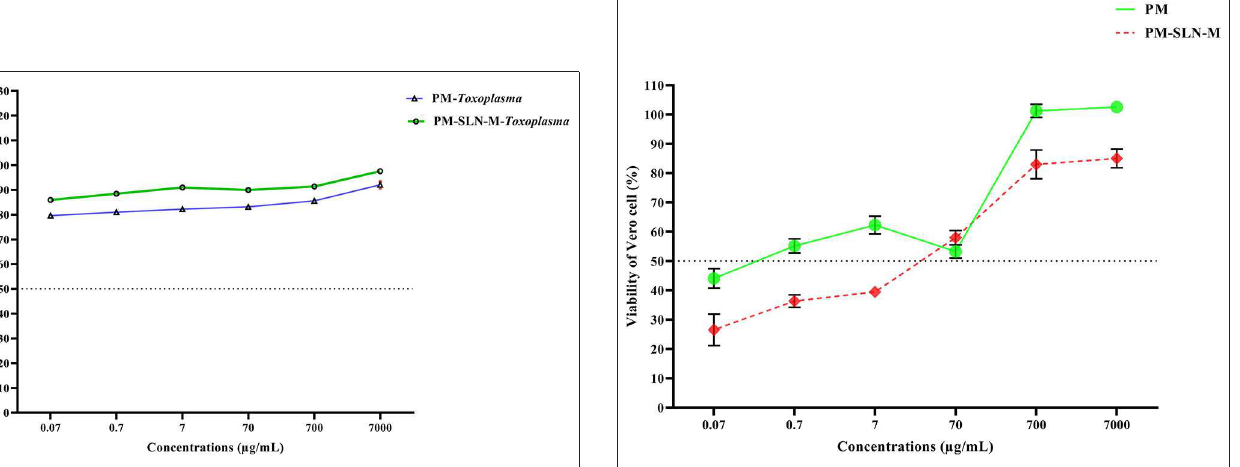
FIGURE 5 | The effects of different concentrations of PM and PM-SLN-M on intracellular Toxoplasma .